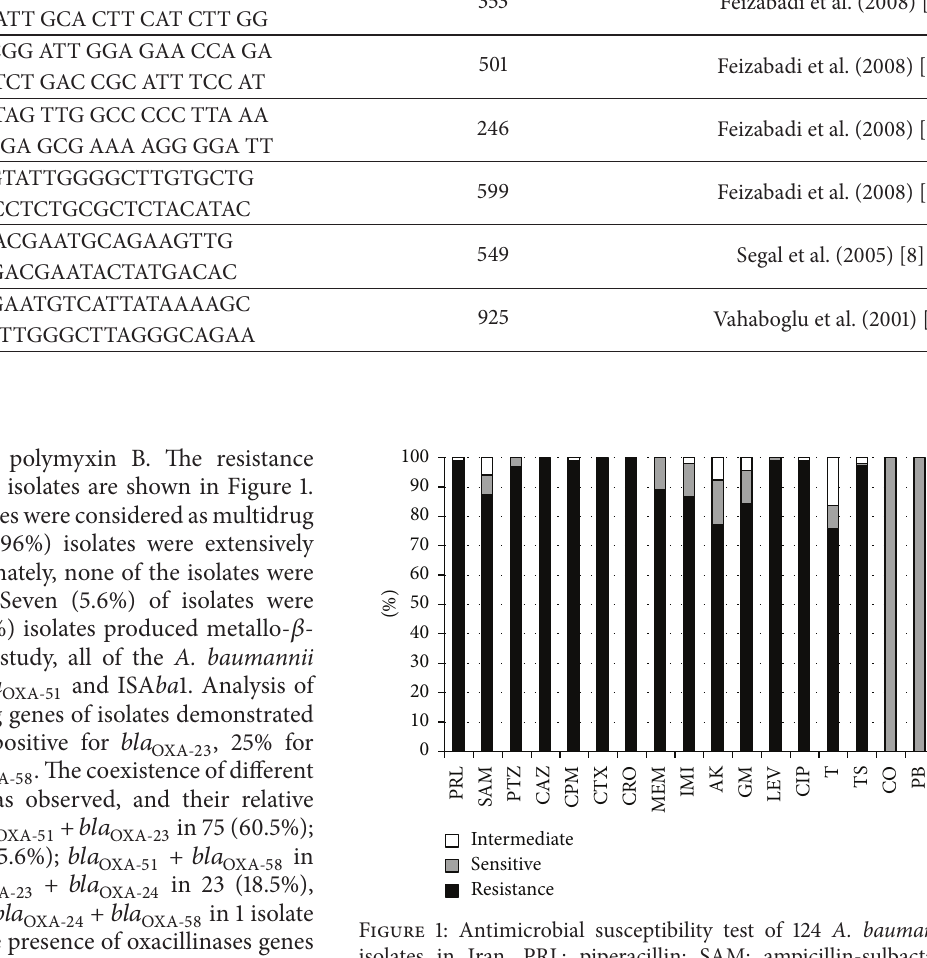
Table 1: Primers used in this study for amplification of genes from Acinetobacter baumannii isolates. Primer